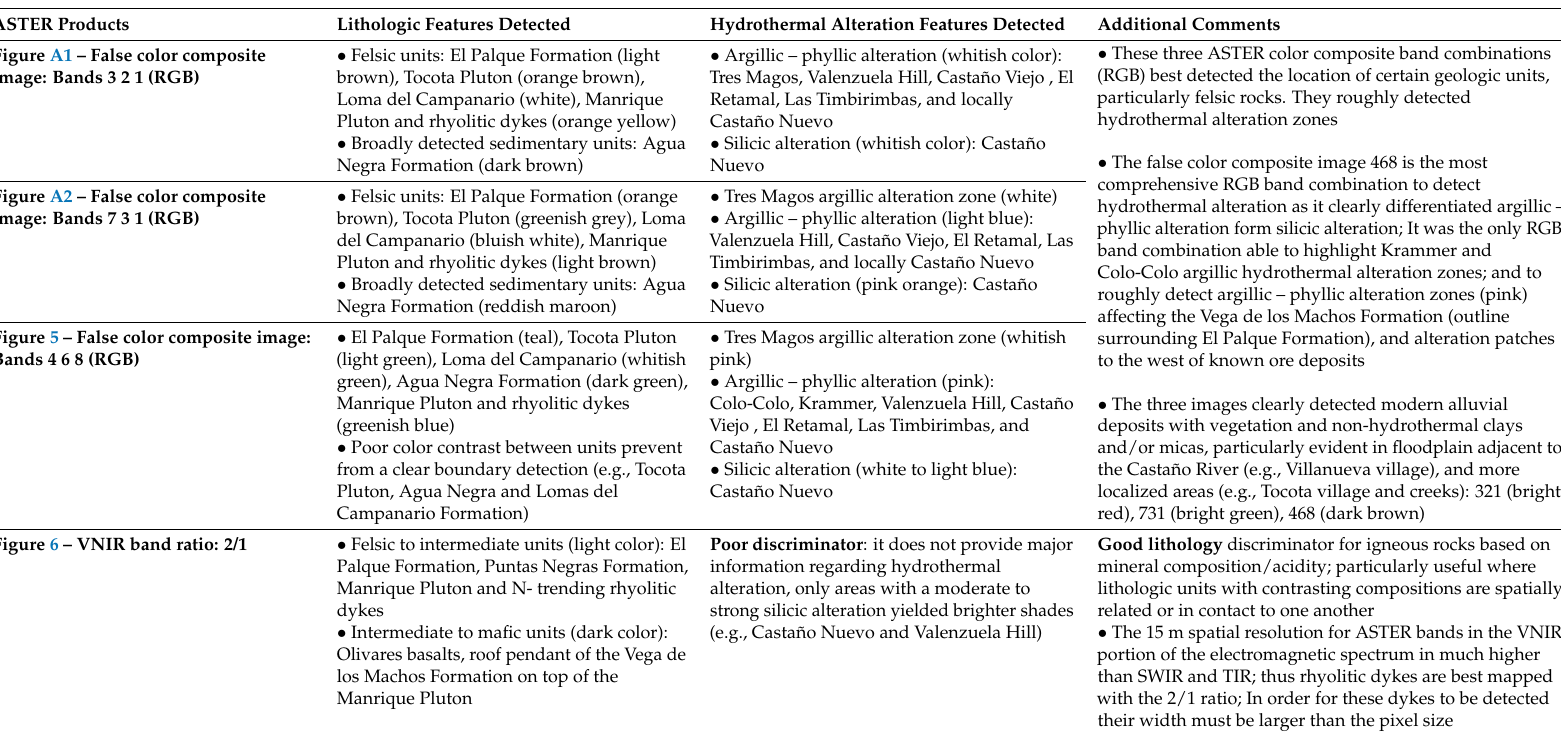
Table A3. Summary of lithologic units and hydrothermal alteration types detected by the ASTER products presented in this study. This table lists pros and cons, and discuses each processing method applied based on our interpretations and available literature.